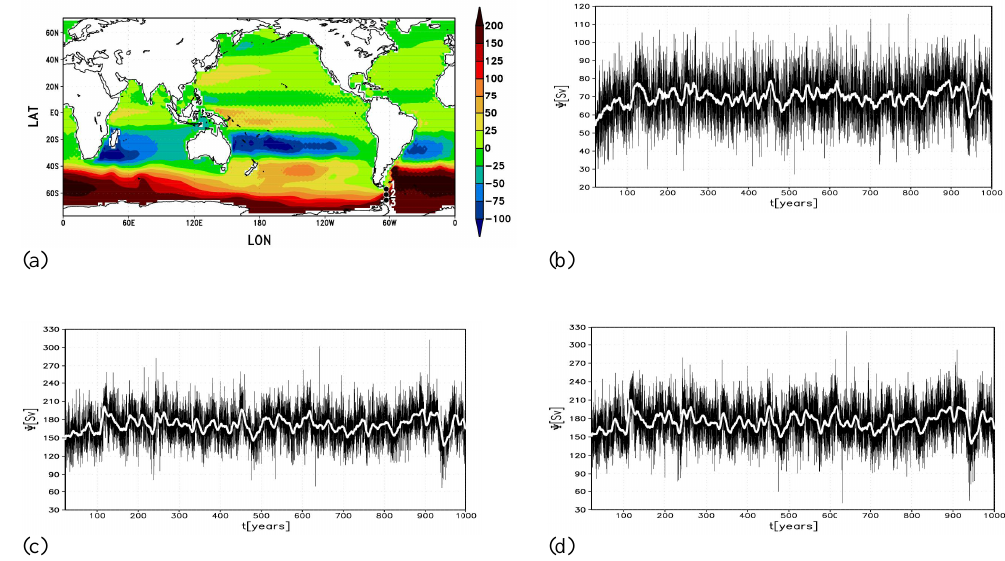
Fig. 4. (a) Time-mean of the oceanic streamfunction 9 (in Sv) over last 10yr of the coupled atmosphere-ocean model run. Numbers 1, 2, 3 mark the grid points in the Drake Passage for which a transient behaviour of 9 is shown. White lines indicate the gliding mean of the stream function. (b) 9 -values (Sv) for the grid point with coordinates 59 ◦ S and 91 ◦ W (point 1 in a ) over 1000yr. (c) The same as in (b) , but for 61 ◦ S (point 2 in a ). (d) The same as in (b) and (c) , but for 63 ◦ S (point 3 in a ) .